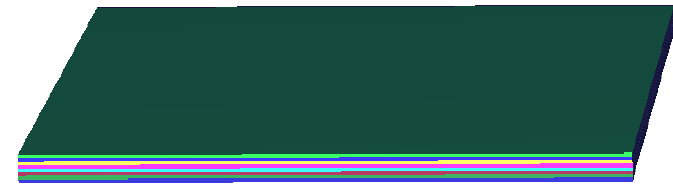
Figure 2. Geometry of laminated composite.